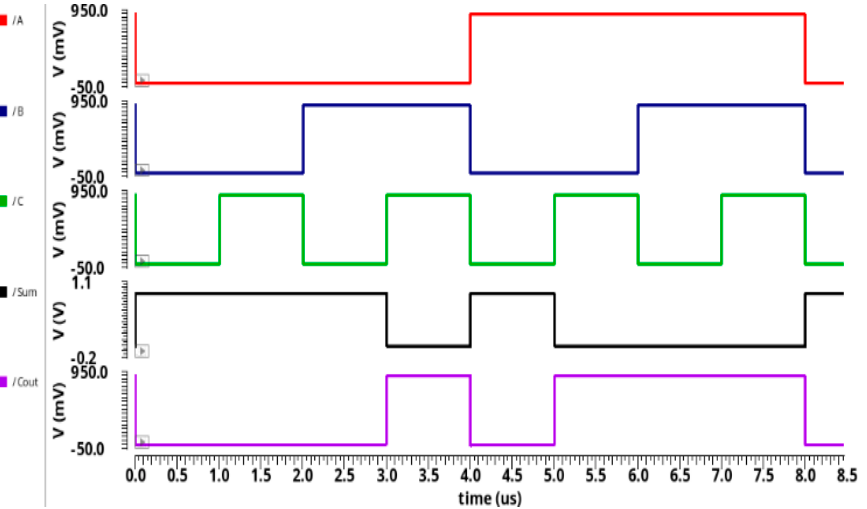
Figure 9. Proposed 13T AA transient analysis.